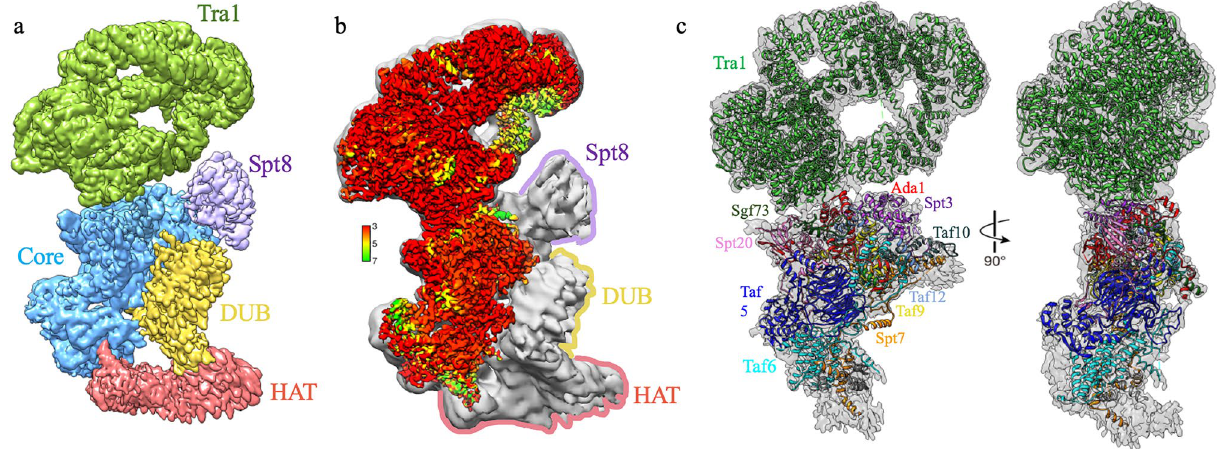
Figure 2. Structure of the S. cerevisiae SAGA complex. ( a ) Cryo-EM reconstruction of SAGA. Tra1, core, HAT, DUB modules and Spt8 subunit are indicated by color. The different regions were segmented using UCSF Chimera and verified by fitting the available high-resolution structural model of the Tra1 subunit and the SAGA core module. ( b ) Low-pass-filtered SAGA reconstruction and high-resolution cryo-EM map coloured according to local resolution. ( c ) Front and side views of the SAGA complex with the SAGA cryo-EM structure (displayed as a ribbon model) from Wang et al. 24 fit into the map. The subunits of Tra1 and core modules are indicated by color. All illustrations were prepared using UCSF Chimera 31